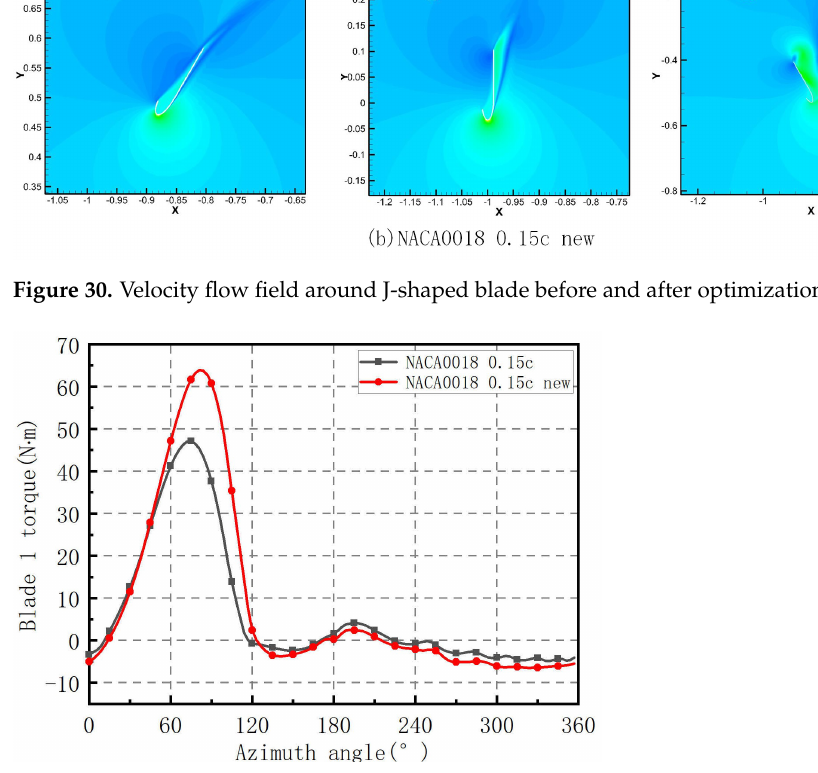
Figure 31. Torque of J-blade wind generator before and after optimization (TSR = 1.5).